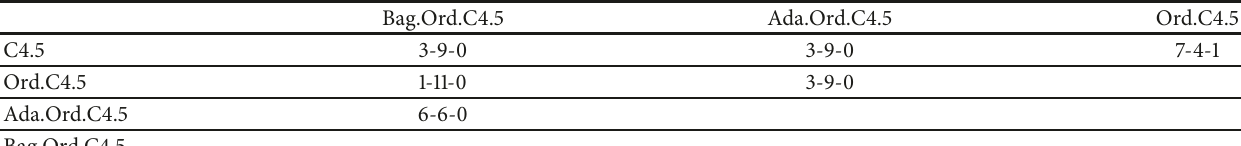
Table 6: The pairwise combinations of the C4.5 algorithm with ordinal and ensemble learning versions.